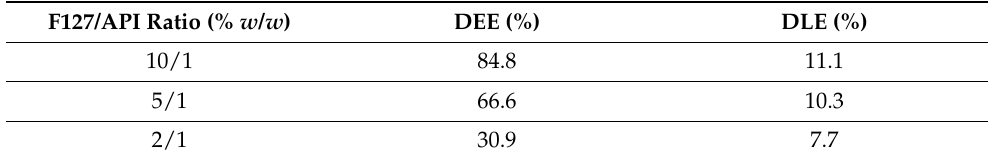
Table 2. DEE and DLE values for API-loaded PMs.